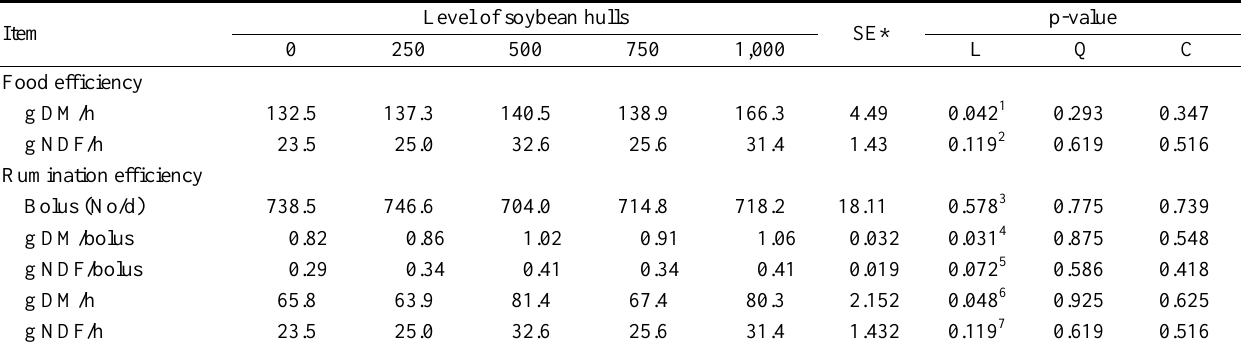
Table 4. Food and rumination efficiency (g DM and NDF/h) of lambs fed diets containing different levels of soybean hulls as a substitute for corn